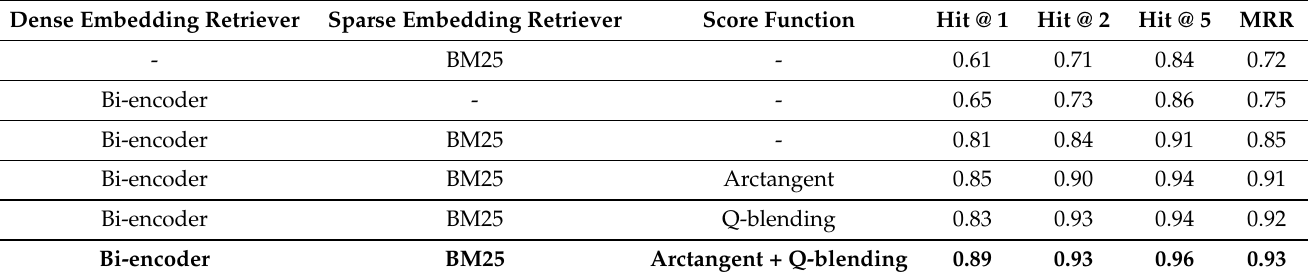
Table 4. Performance of dense and sparse embedding retrievers for FAQ database.